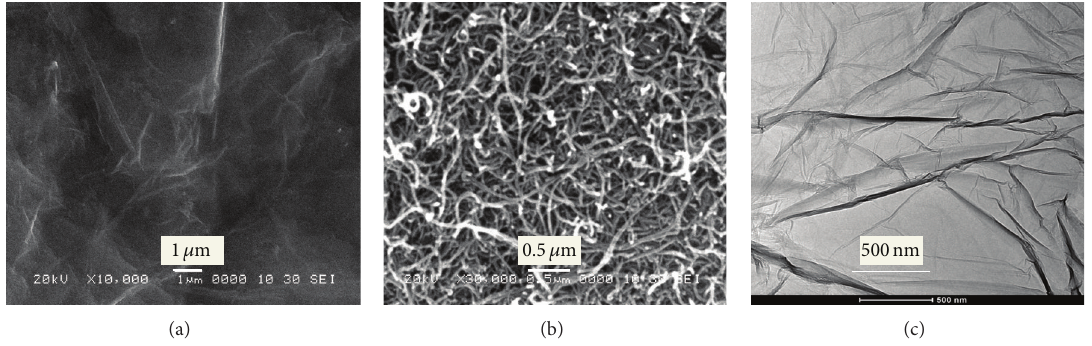
Figure 5: SEM micrographs of (a) GO, (b) MWCNTs, and (c) TEM micrograph of